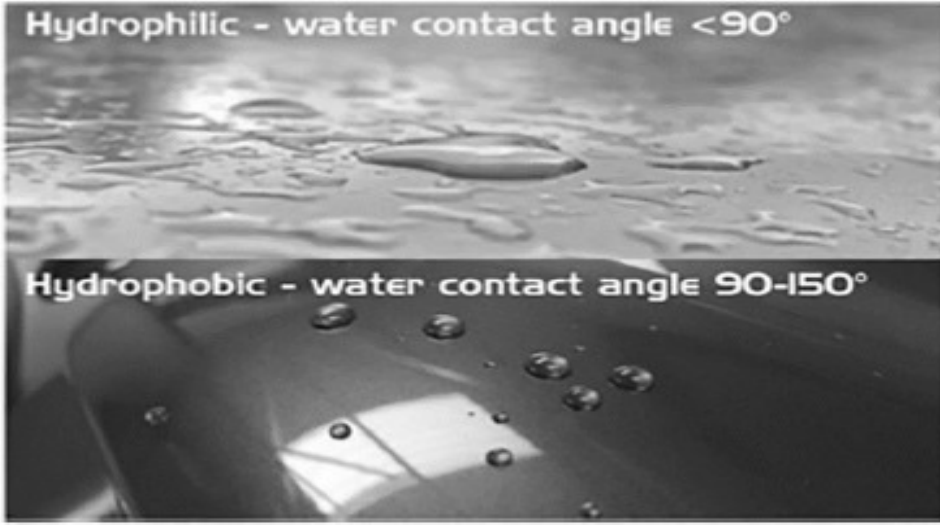
Figure 36. Water droplets on the hydrophilic surface versus the hydrophobic surface [152].